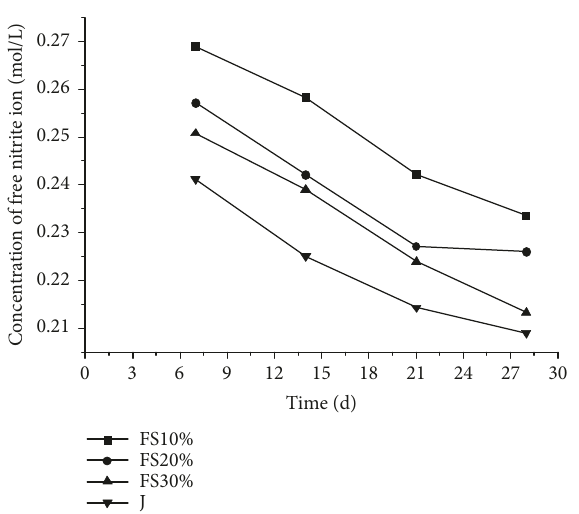
Figure 4: The free nitrite ion concentration curves of specimens B1- B3 and reference (J) group.